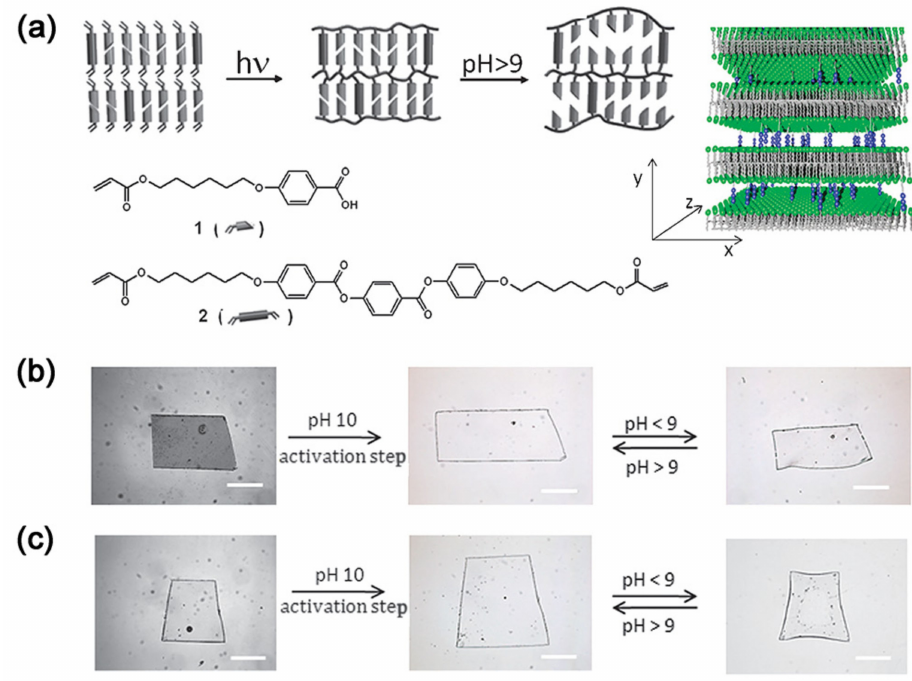
Figure 5. ( a ) Schematic representation of the formation of a smectic hydrogel based on LC monomers, and the swelling at high pH value. The 3D figure illustrates the nanopores formed by hydrogen bridges. ( b ) Swelling and deswelling of thin films of a planar-aligned smectic network ( c ) and a homeotropic smectic network (scale bar corresponds to 500 µ ). Reprinted with permission from reference [113]. Copyright (2012) Royal Society of